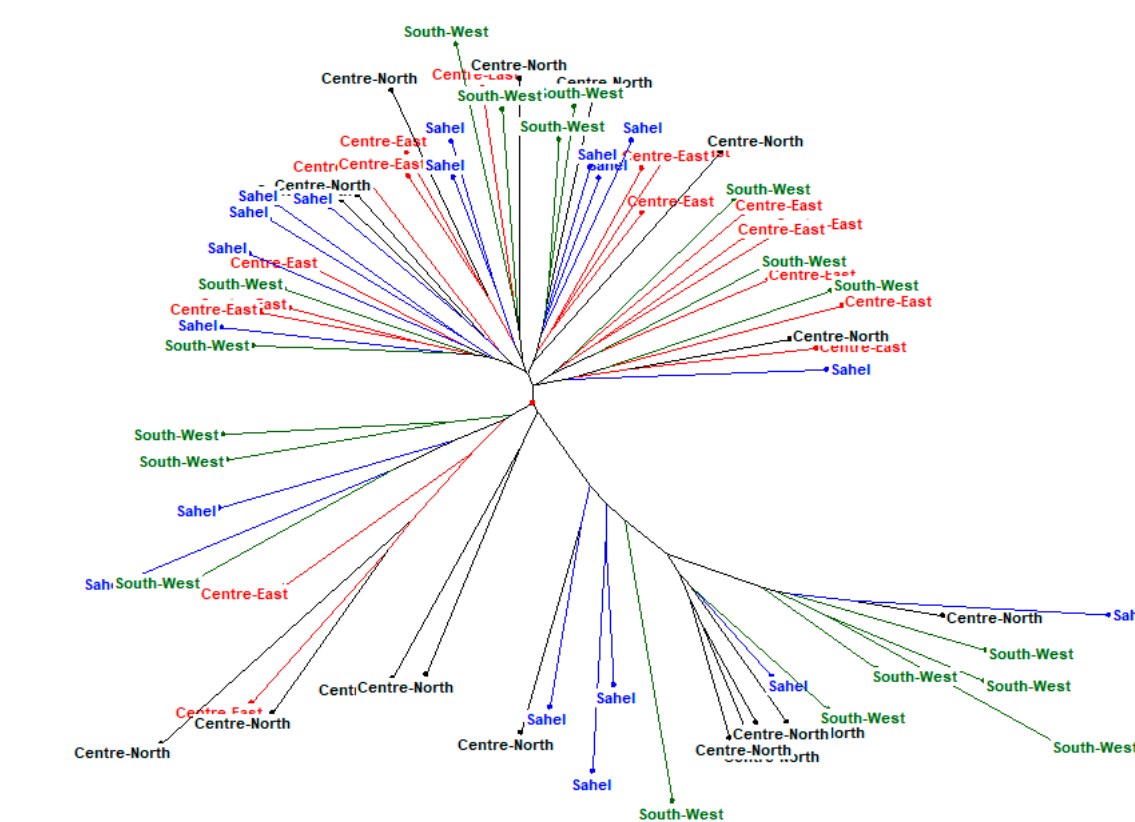
Figure 4. Phylogenetic tree based on the neighbour-joining describing the relationships between local chickens in the Centre-East (Konde ecotype), Centre-North, Sahel and South-West regions of Burkina Faso.